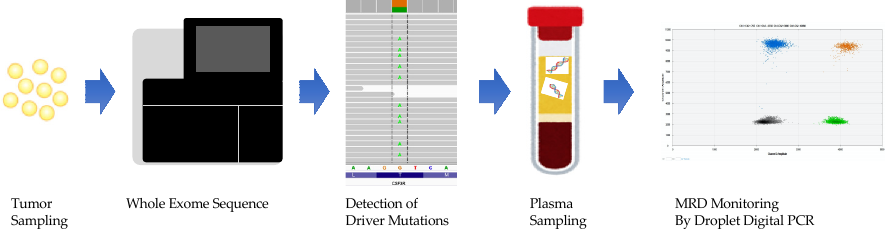
Figure 1. Whole-exome sequencing of bone marrow fluid before treatment to identify driver muta- tions and monitoring of minimal residual disease (MRD) by creating a droplet digital PCR assay for each patient.